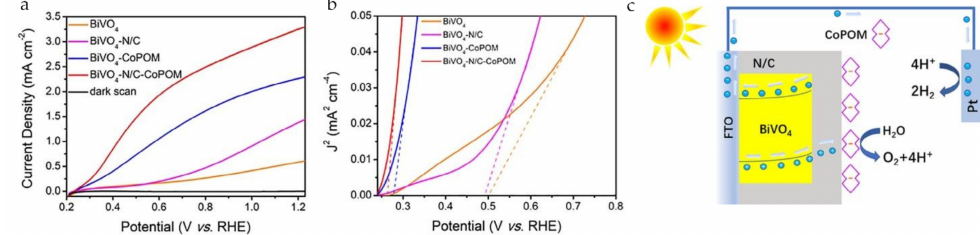
Figure 12. ( a ) PEC performances of BiVO 4 , BiVO 4 –N/C, BiVO 4 –CoPOM, and BiVO 4 –N/C–CoPOM. LSV curves under AM 1.5G illumination, ( b ) Bulter plots, and ( c ) Graphical abstract